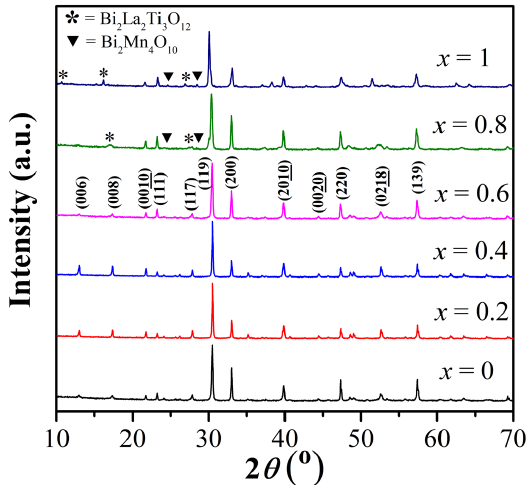
Figure 2. Le Bail plot of XRD powder of Ca Bi LaTi Mn O x = 0, 0.2, 0.4, and 0.6. Observed XRD intensity (circle), calculated 1- x 3+ x 4- x x 15 data (solid line), and the difference of patterns, y La Ti O and Bi Mn O on the bottom curve). The tick marks represent the positions of 2 2 3 12 2 4 10 allowed Bragg reflections in the phase of A 2